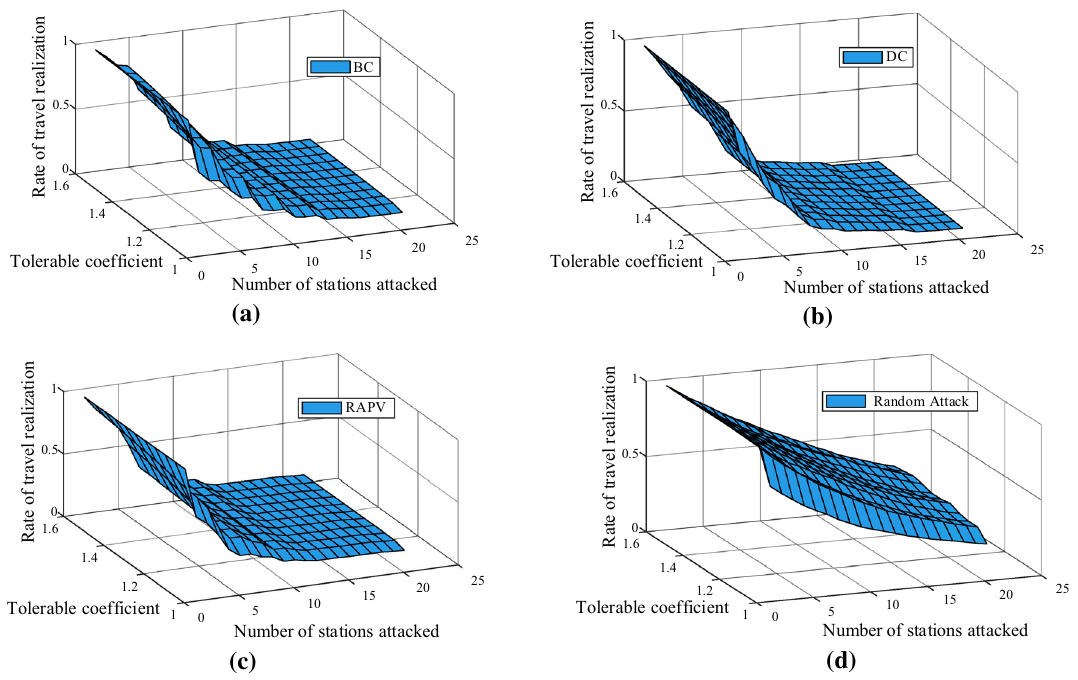
Fig. 6 Sensitivity analysis of the effect of the passenger tolerability coefficient on the rate of tolerable travel paths on Wuhan’s subway network during peak